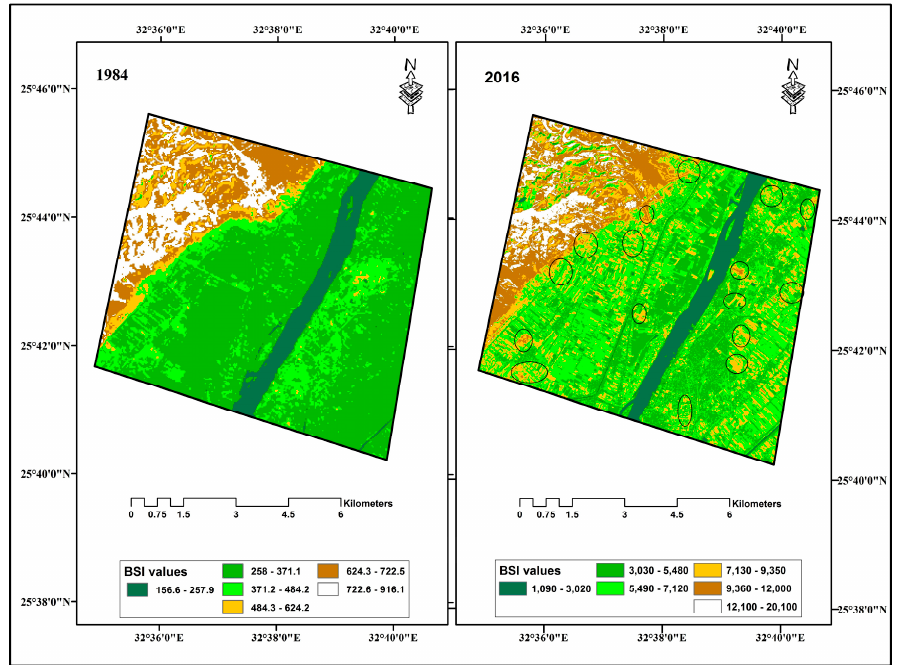
Figure 15. The changes in bare soil index (BSI) indices in the area between 1984 and 2016.